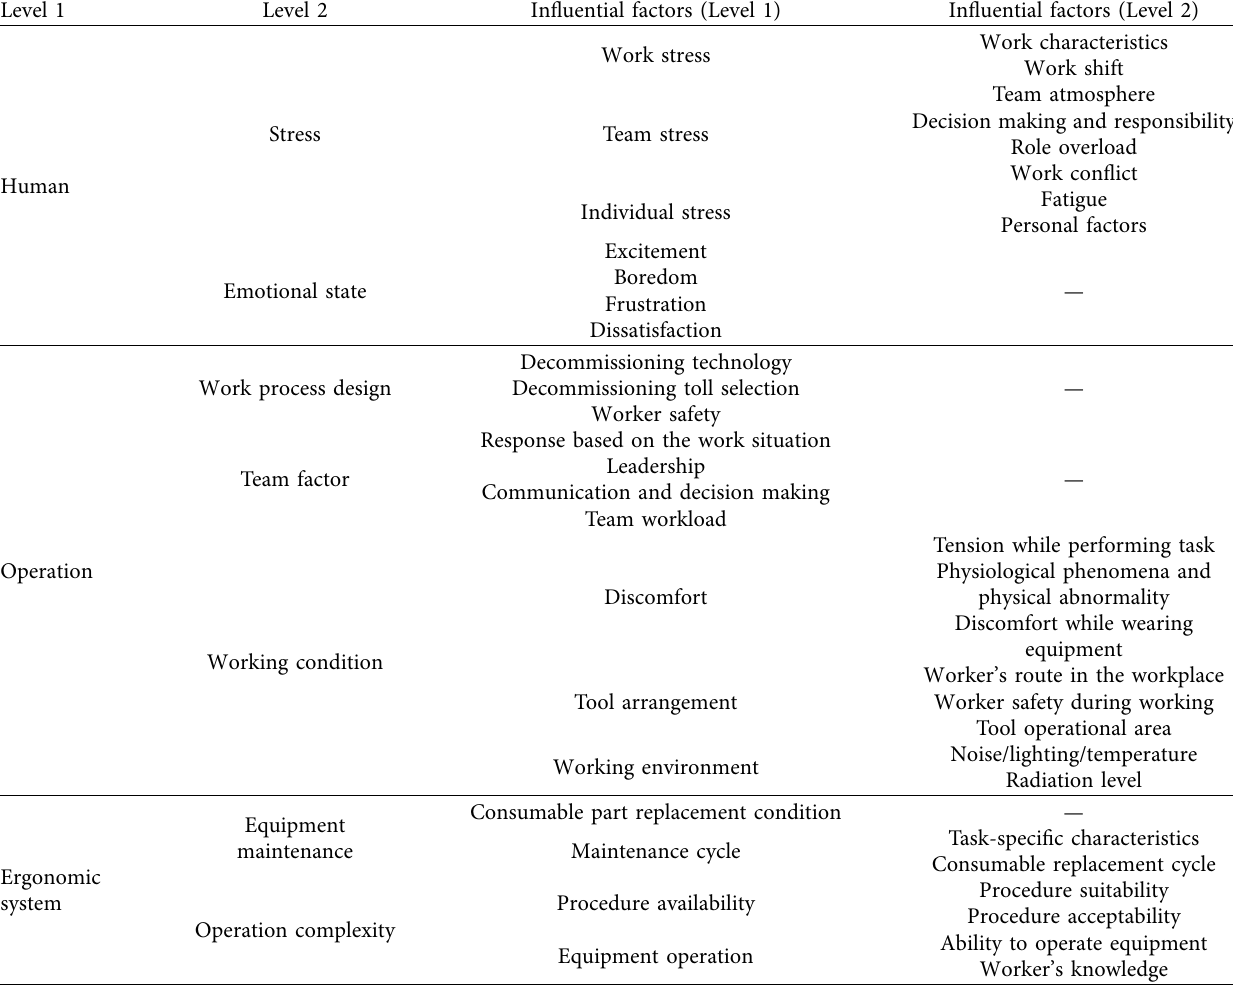
Table 1: PSFs for nuclear power plant decommissioning